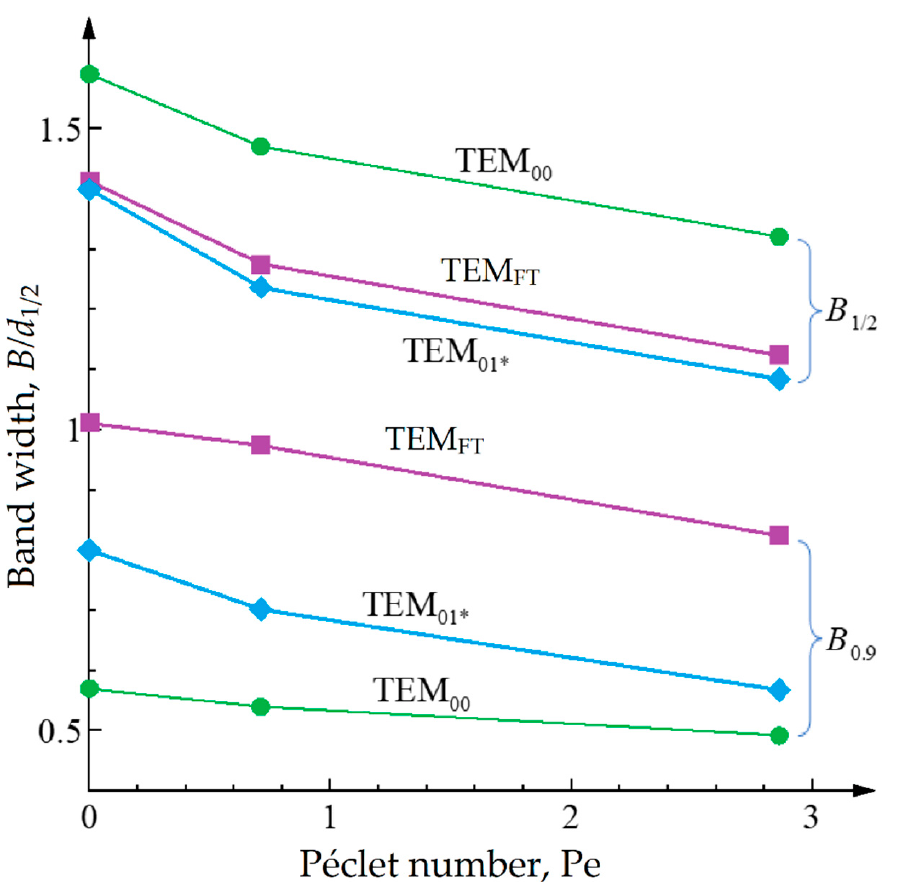
Figure 6. Widths of the laser treated band B 1/2 and B 0.9 versus P é clet’s